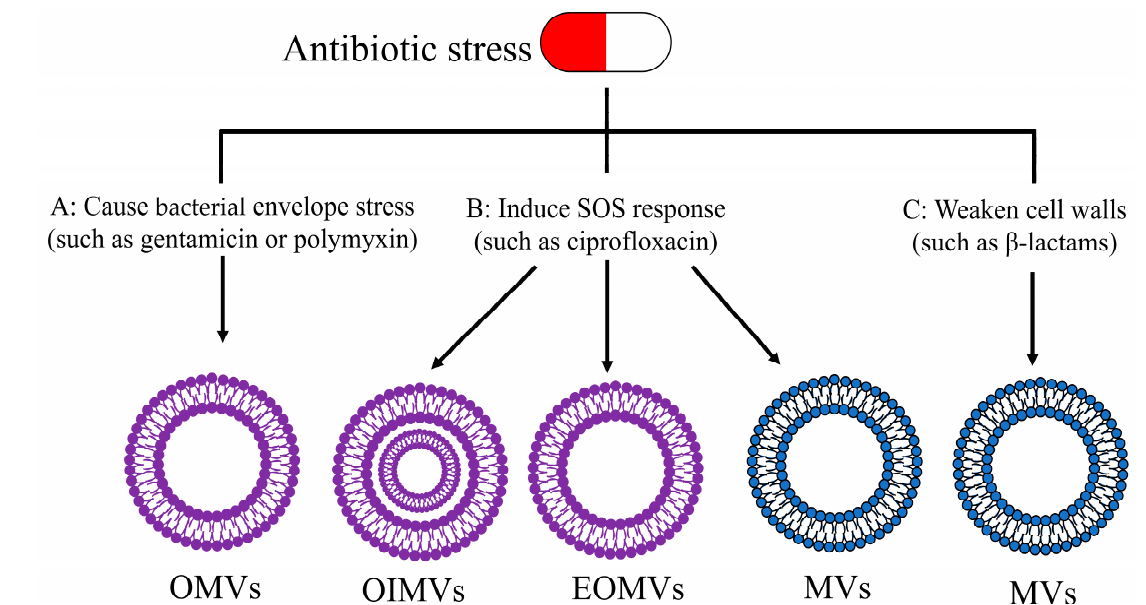
Figure 4. Three mechanisms of BMV formation under antibiotic stress.